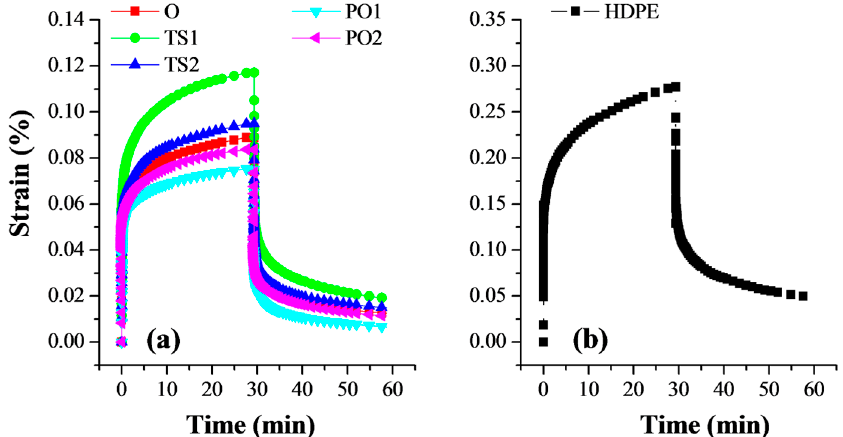
Figure 8. Creep-recovery curves of ( a ) pulp fiber/HDPE composites and ( b ) neat HDPE. Composite O: wet pulp fiber/HDPE mixture was dried by oven. Composite TS1: wet pulp fiber/HDPE mixture